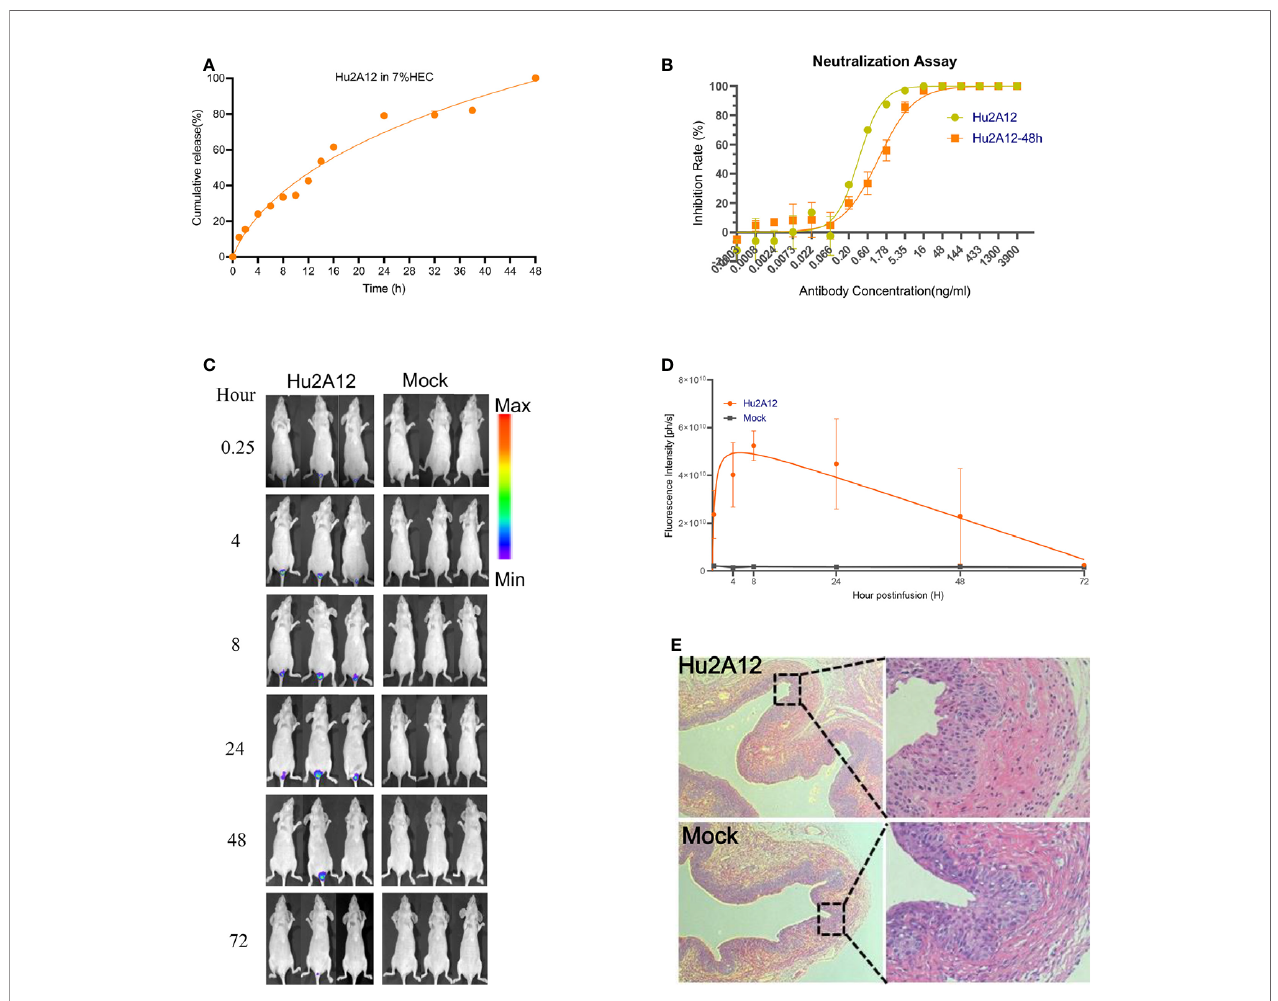
FIGURE 6 | Characterization of Hu2A12 in gel. (A) The release of Hu2A12 in gel was determined at the indicated time. Data represent mean ± SEM. (B) Neutralization activity of Hu2A12 and Hu2A12 released from the gel at 48 h (Hu2A12-48h). Data represent mean ± SEM. (C) Sequential in vivo imaging of Hu2A12-750 conjugated with dye YF750 injected into the vagina of nude mice. (D) . Fluorescence intensity (ph/s) of mice shown in (C) . Data represent mean ± SEM. (E) Representative vaginal sections of mice from Hu2A12 in hydrogel and Mock group in (B) were analyzed by H&E staining. The right panel is enlarged images as indicated by rectangle.Images were visualized under ×10 objective lens. All experiments of (B, D, E) were repeated